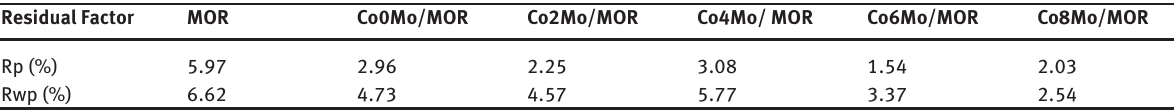
Table 2: Residual factor value (Rp and Rwp) from the refinement results. Residual Factor